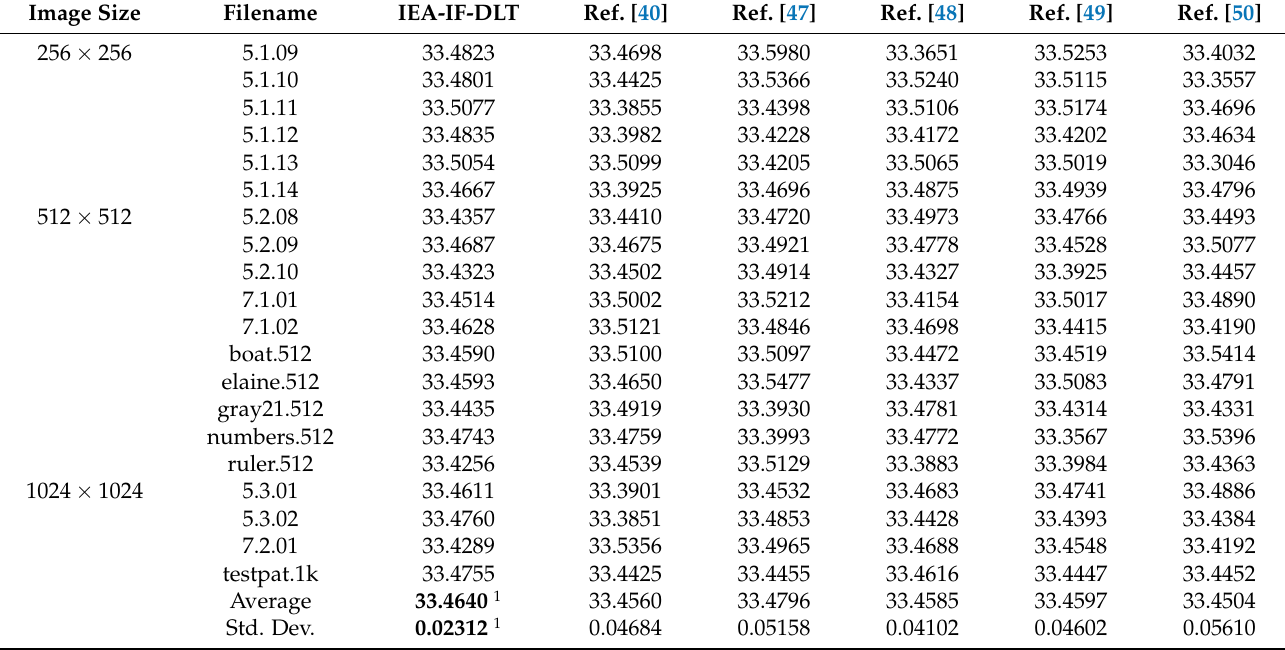
Table 4. UACI test results of IEA-IF-DLT and other image encryption